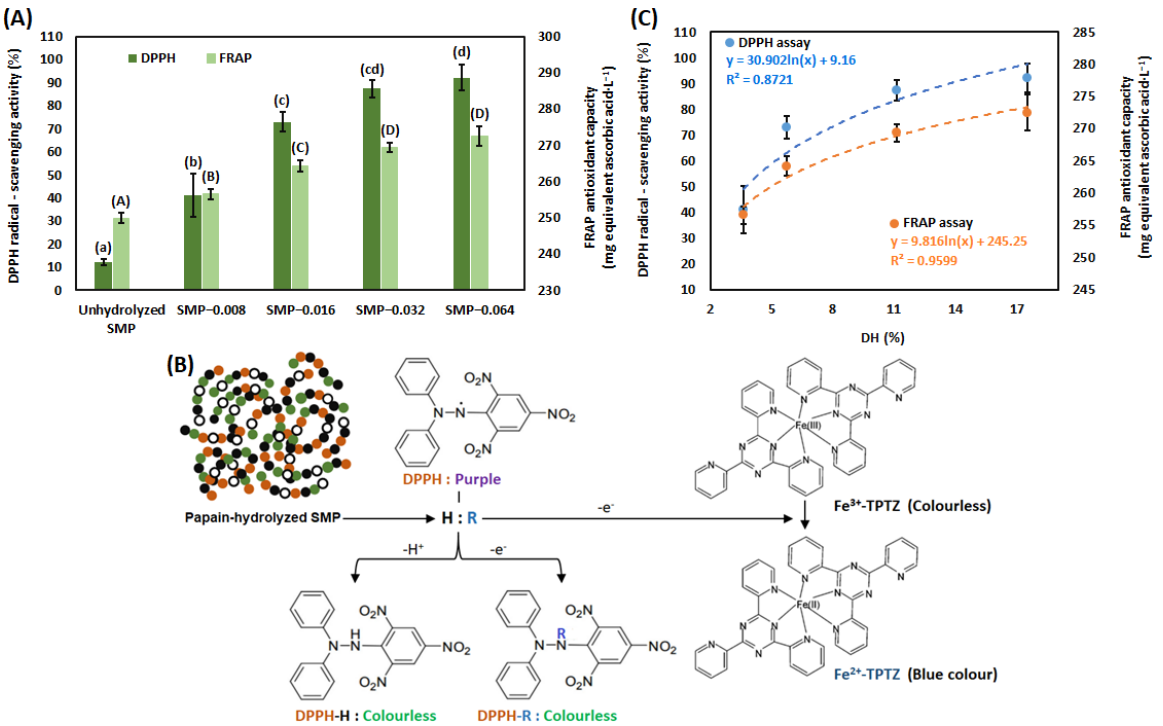
Figure 2. Antioxidant capacity of unhydrolyzed and papain-hydrolyzed SMP ( A ). Mechanisms of antioxidant capacity for papain-hydrolyzed SMP ( B ). Antioxidant capacity of papain-hydrolyzed SMP with respect of DH (%) ( C ). Results are presented by mean value with standard deviation (± values). The dissimilar alphabet in superscript represents the significant difference between results, evaluated by the Tukey’s post hoc method.